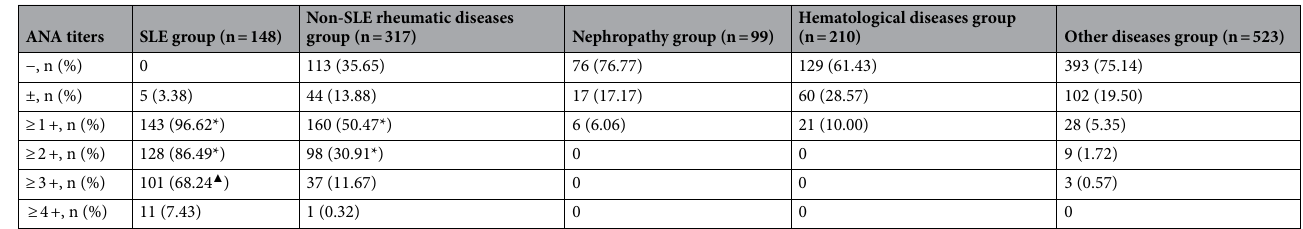
Table 2. Comparison of the proportions of patients with different levels of ANA titers between groups. ± : weak positive. * p < 0.01, compared with Nephropathy group, Hematological diseases group, and Other diseases group ▲ p < 0.01, compared with Non-SLE rheumatic diseases group. ANA antinuclear antibody, SLE systemic lupus erythematosus.